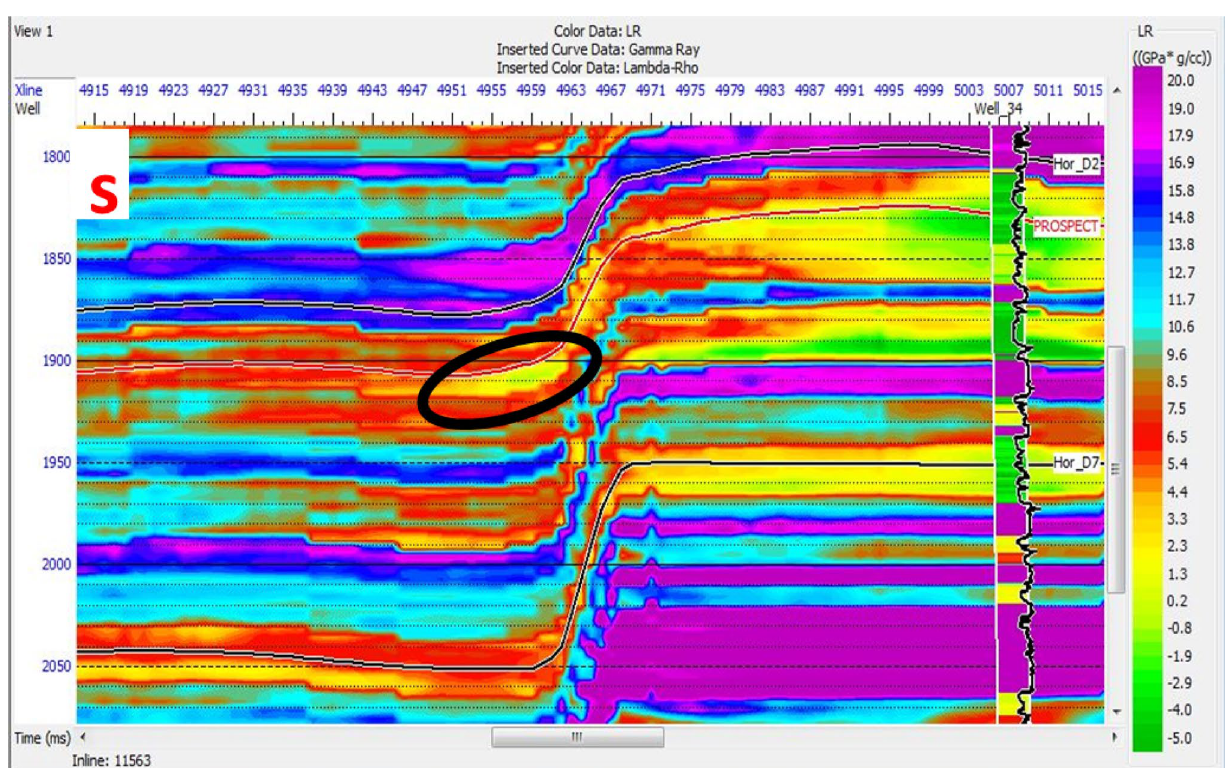
Fig. 10 Lambda Rho attribute of inline 11,563 showing variation around the exploited and prospective